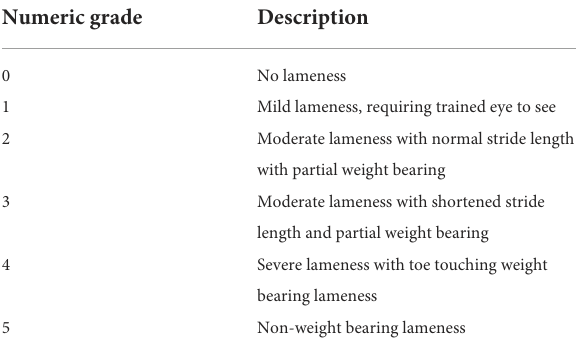
TABLE 1 Subjective lameness